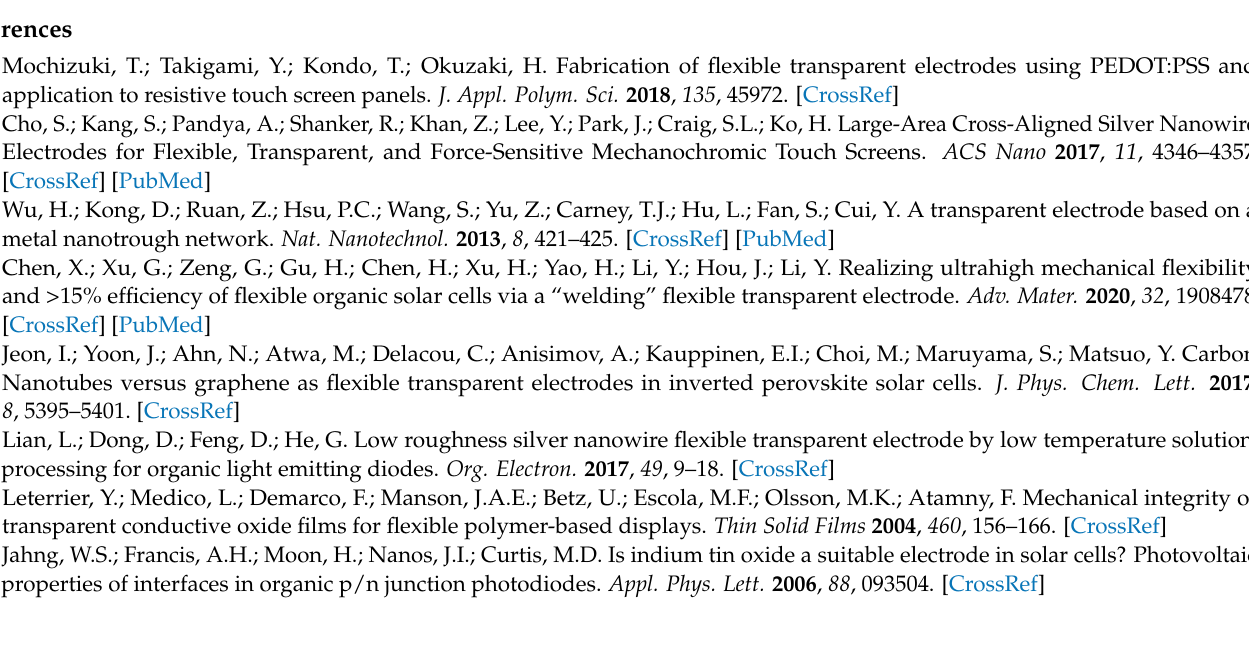
Doubling-Adding algorithm; Figure S2. Schematic representation of the experimental setup employed to measure the scattering anisotropy